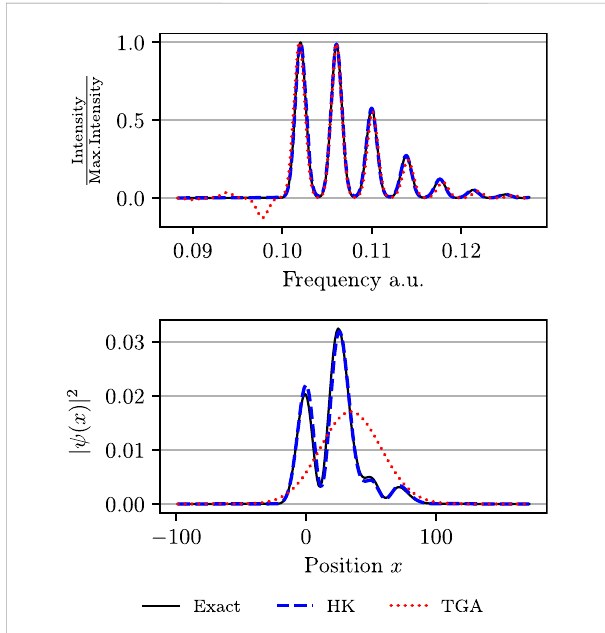
FIGURE 1 Upper panel: Spectra of a Morse potential evaluated using the exact quantum dynamics, Herman – Kluk (HK) propagator, and thawed Gaussian approximation (TGA). Both approximations yield accurate results. Lower panel: Position density at time t ≈ 392 fs propagated in the same Morse potential. In contrast to the Herman – Kluk propagator, the thawed Gaussian approximation does not capture interference between faster and slower components of the wavepacket. For more details, see the last paragraph of Section